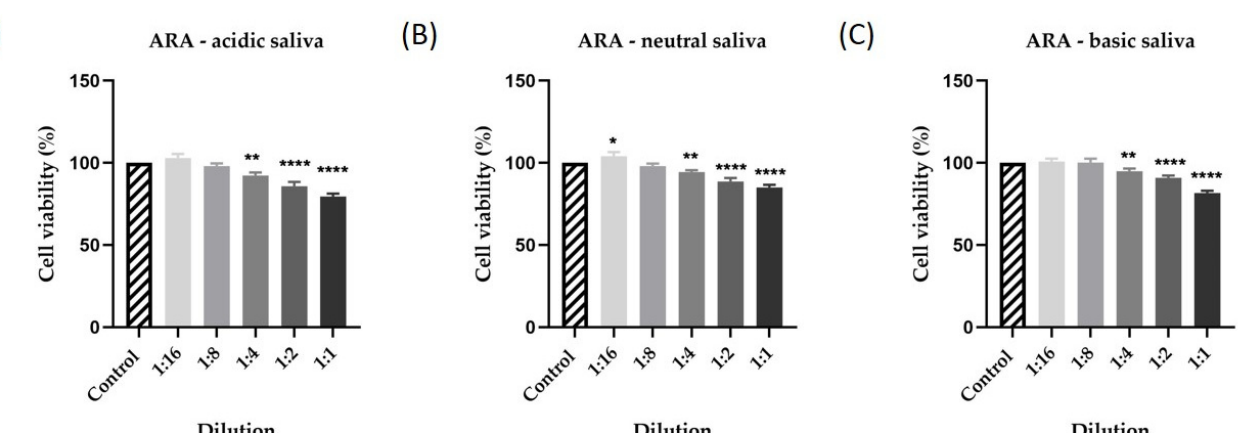
Figure 4. In vitro evaluation of the effect exerted by DM suspended in ( A ) acidic saliva (pH = 3), ( B ) neutral saliva (pH = 7), and ( C ) basic saliva (pH = 10) on the viability of human keratinocytes - HaCaT cells following a 24 h treatment by performing the 3-(4,5-dimethylthiazol-2-yl)-2,5-diphenyltetrazolium bromide (MTT) assay. Five different dilutions were tested (1:16, 1:8, 1:4, 1:2, 1:1). Data are presented as viability percentages (%) normalized to control and expressed as mean values ± SD of three independent experiments performed in triplicate. The statistical differences between the control and the treated group were verified by applying the one-way ANOVA analysis followed by Dunett’s multiple comparisons post-test (* p < 0.1).